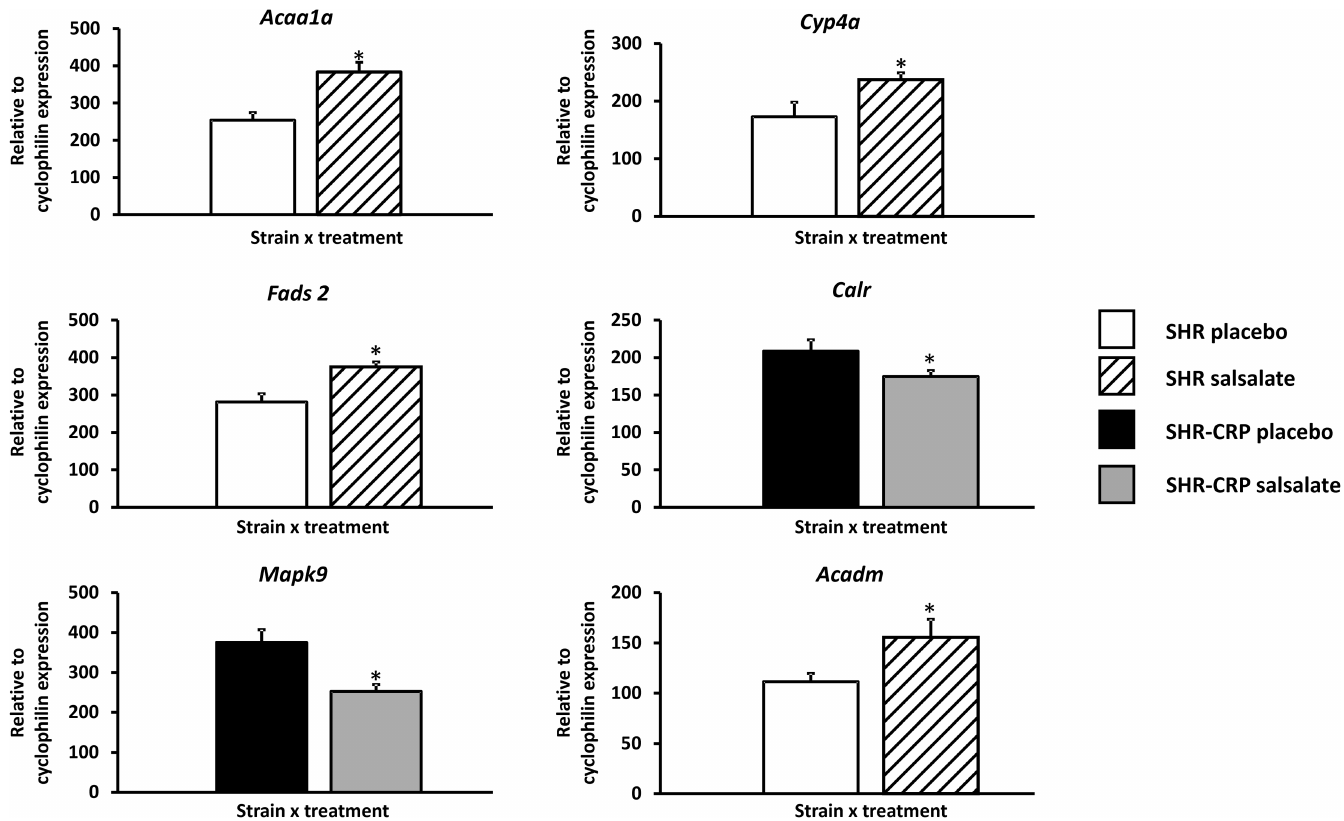
Fig 5. Validation of directional expression of genes identified by SPIA using quantitative real-time PCR for six transcripts in livers isolated from SHR-CRP rats versus SHR controls treated either with placebo or salsalate. The expressionof selected geneswas normalised relative to the expressionof the peptidylprolyl isomeraseA ( Ppia )(cyclophilin)gene, which served as an internalcontrol. * denotesp < 0.05and p < 0.001.